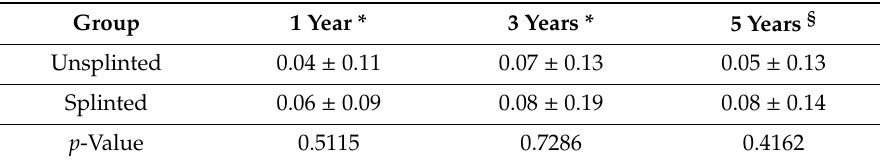
Table 5. Bleeding on probing.